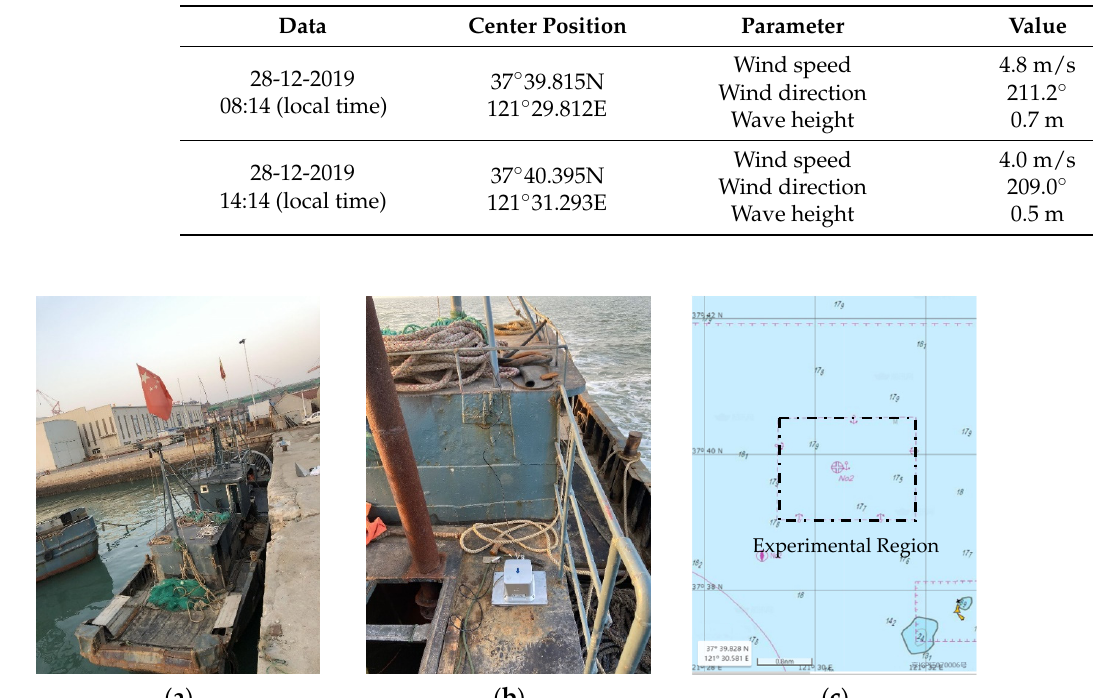
Figure 19. Experimental condition of this test: ( a ) experimental vessel (20 m × 3 m); ( b ) fixed position and appearance of the IMU; ( c ) experimental region (an anchorage near Yantai Port).